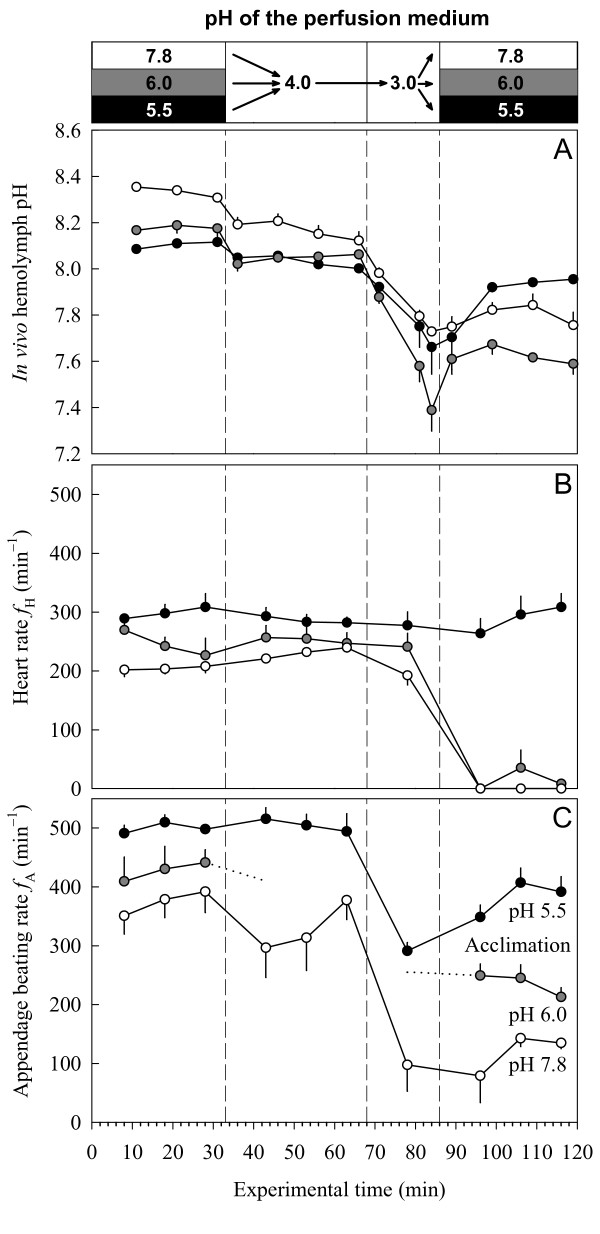
Tolerance to severe acid stress. Influence of ambient pH on in vivo hemolymph pH (A), heart rate (B) and appendage beating rate (C) of animals acclimated to pH 7.8 (open symbols), pH 6.0 (grey-filled symbols), and pH 5.5 (filled symbols). Data are given as means ± S.E. (N = 3–4). Dotted lines indicate a period of irregular limb beating activity. Each acclimation group was exposed to its acclimation pH during the initial and final phases of the experiment.